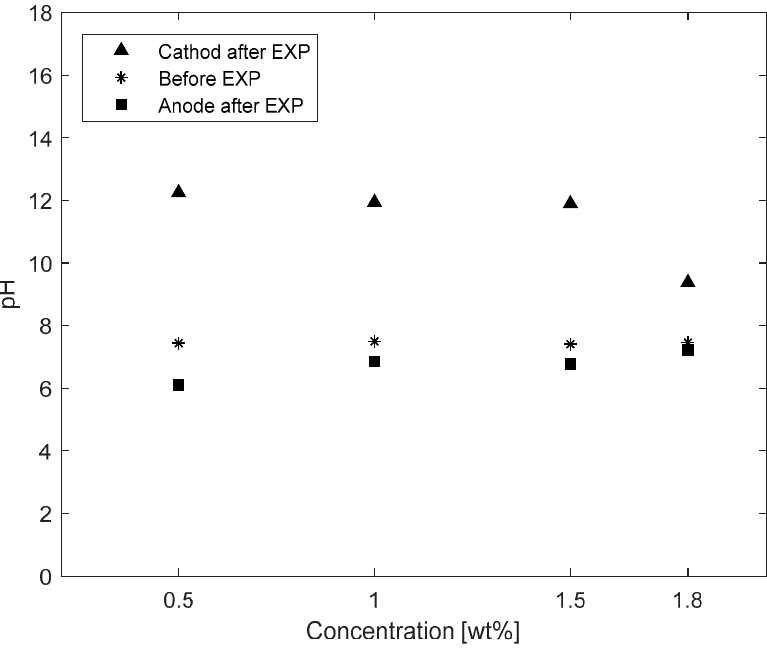
Figure 4. pH change of the electrode before and after the experiment.